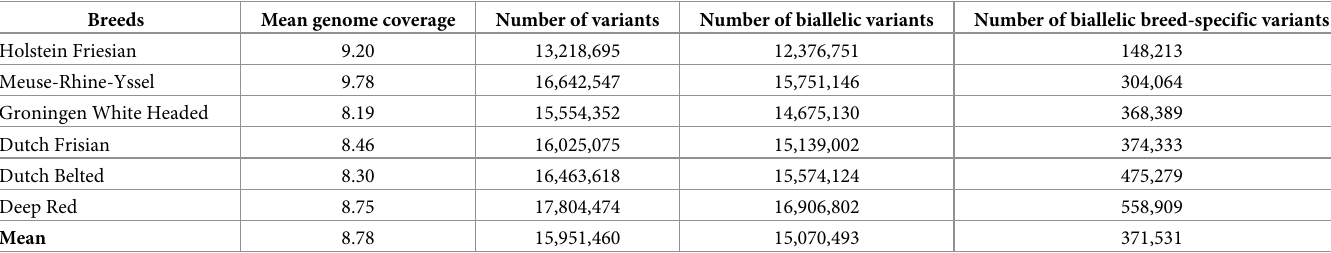
Table 1. Number of variants by breeds and breed-specific variants detected in 6 cattle populations.